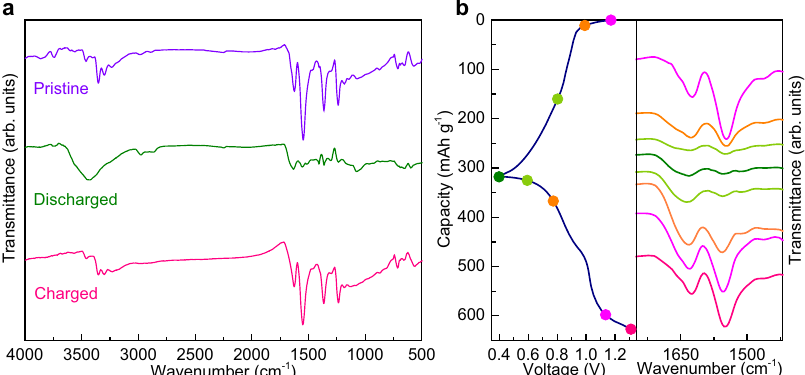
Fig. 3 Ex-situ FT-IR characterizations of TABQ. a FT-IR spectra of the TABQ electrode at the pristine, discharged and charged states. b Detailed FT-IR peak evolution along discharge and